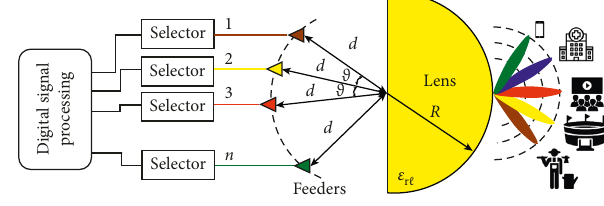
Figure 1: Beamsteering system